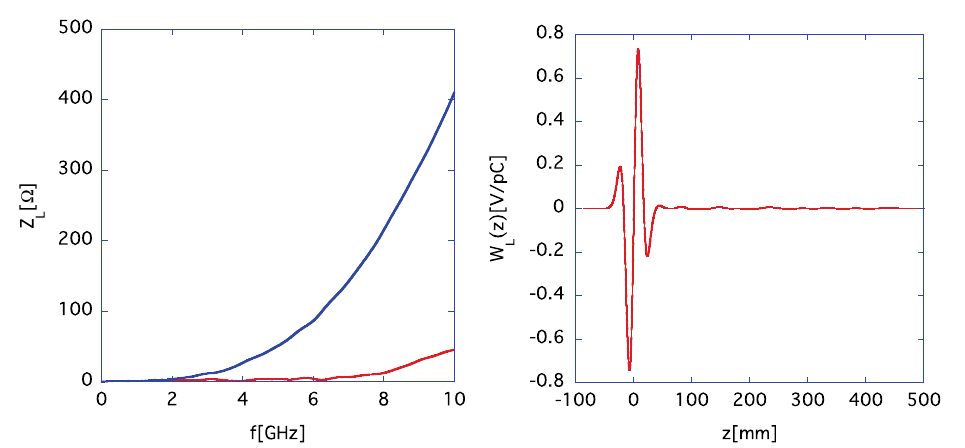
FIG. 25. The longitudinal impedance and the wake function for Linnecar ’ s